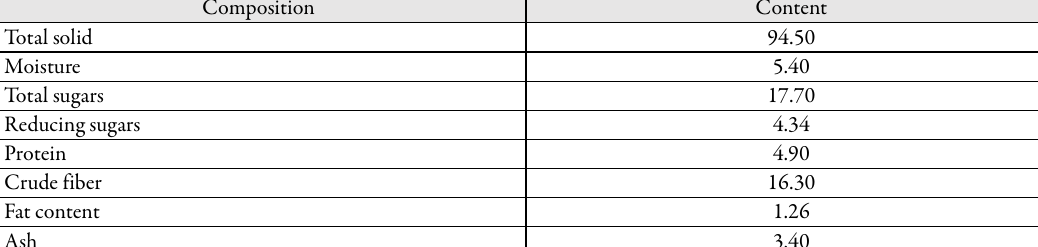
Table 2. Nutrient content of pomegranate peel (per 100 g) (Ahmad et al ., 2018)